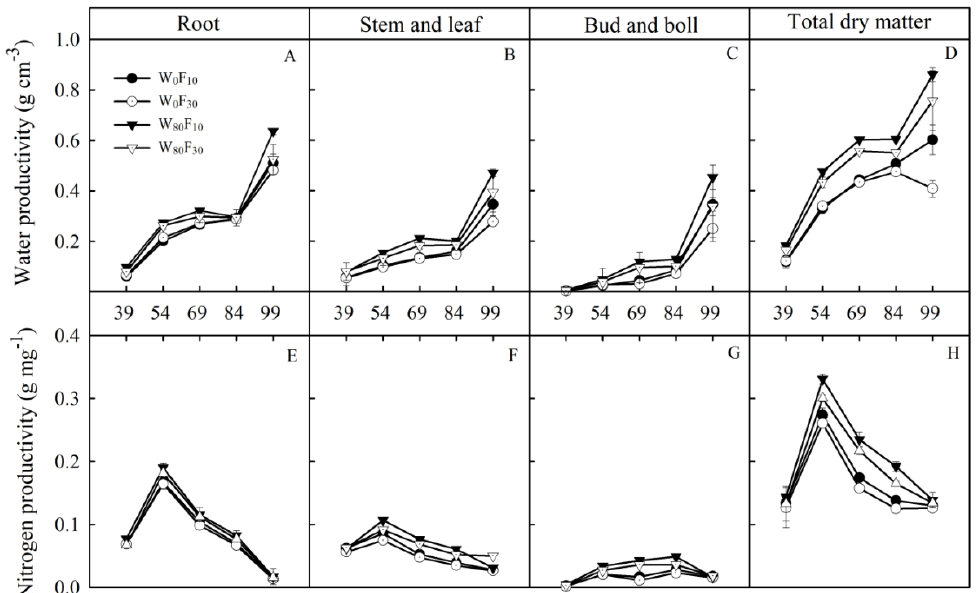
Figure 5. Dynamic change of root (A), stem and leaf (B), bud and boll (C) and total dry matter (D) water productivity and root (E), stem and leaf (F), bud and boll (G) and total dry matter (H) nitrogen productivity plant -1 at pre-sowing irrigation (W 80 ) or no pre-sowing irrigation and basal surface fertilization (F 10 ) or deep (F 30 ) application with the days after emergence (DAE) in 2016. Bars indicate SD ( n = 3).